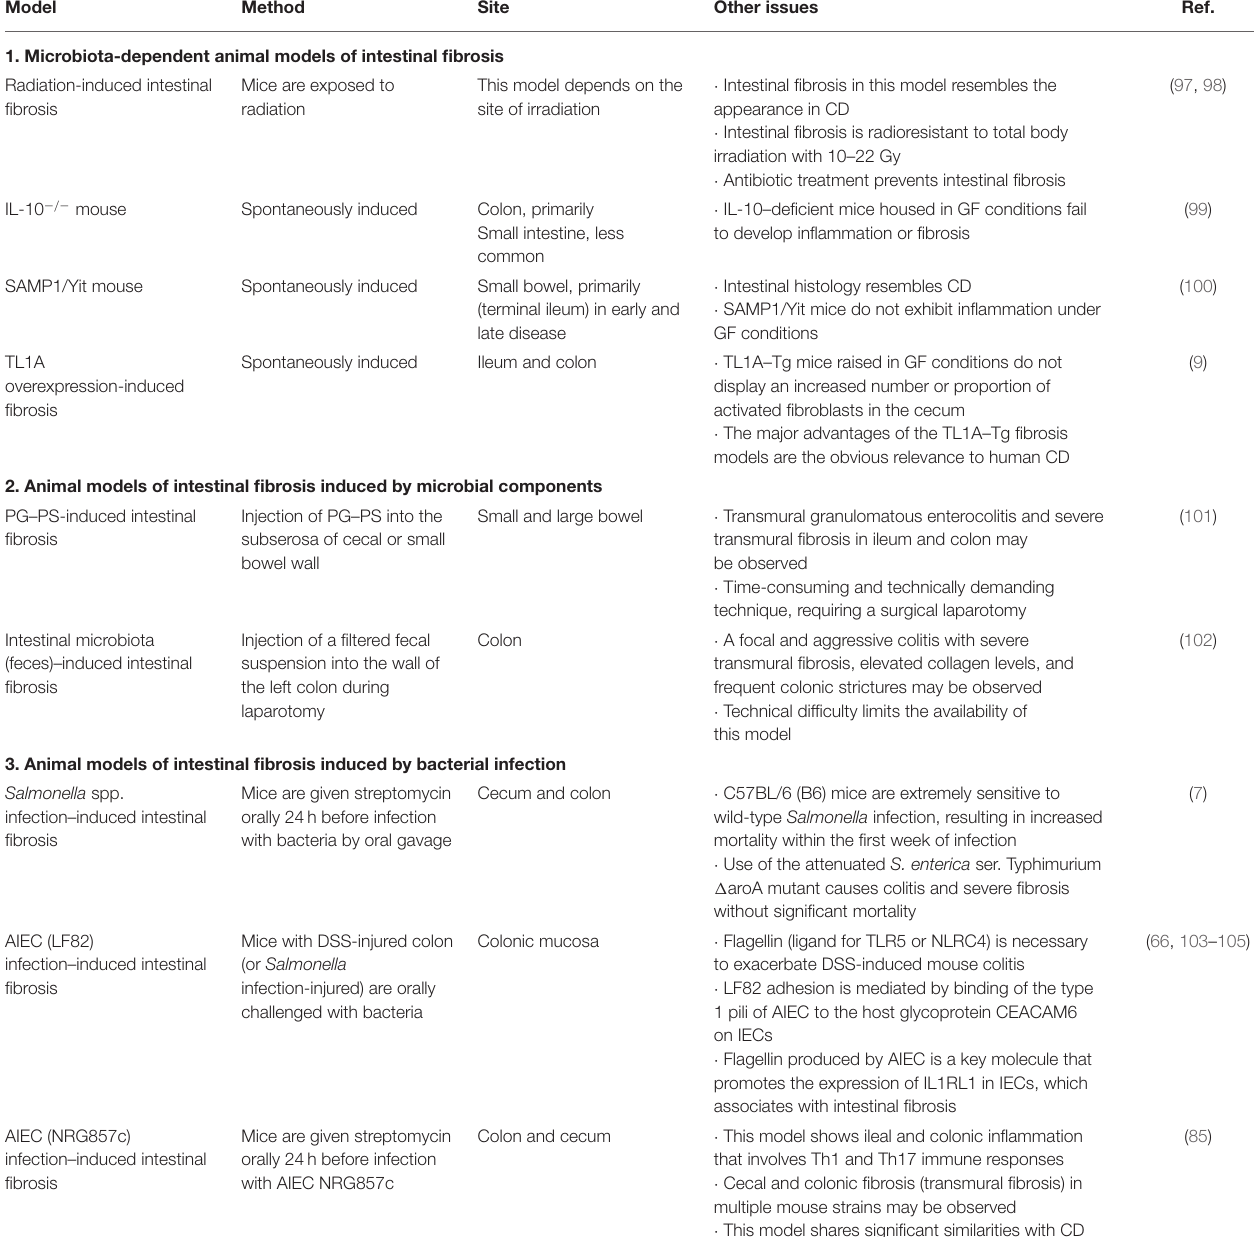
TABLE 1 | Summary of animal models of intestinal fibrosis associated with the gut